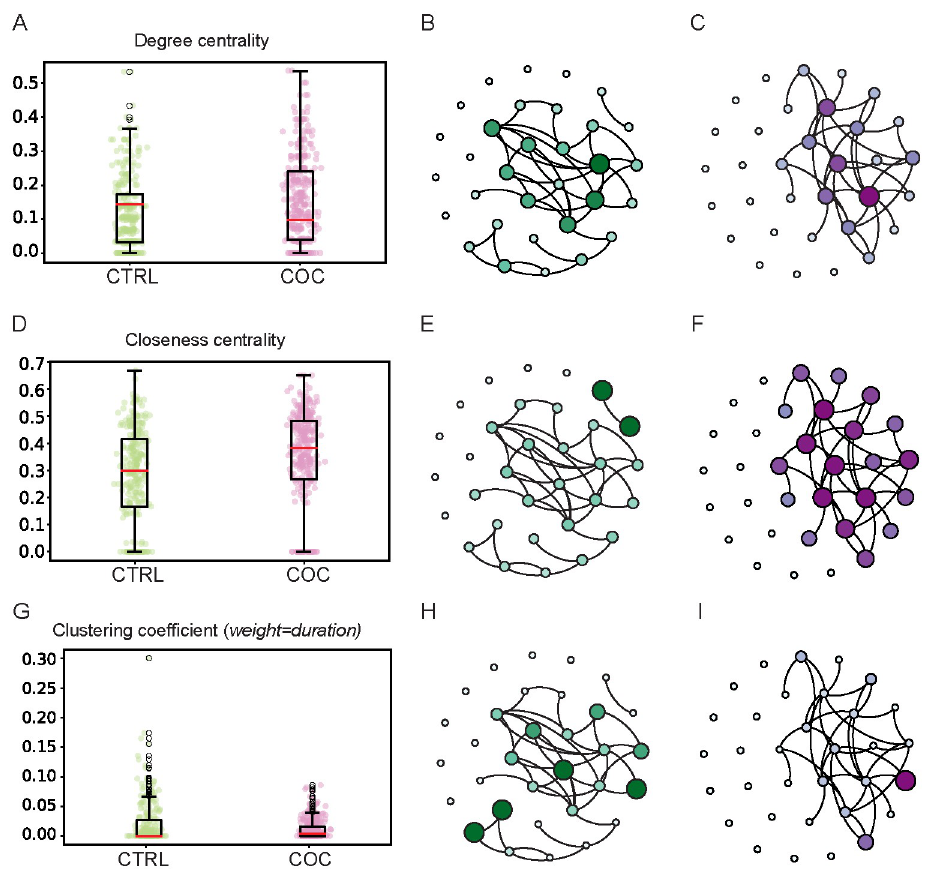
in total where A) shows COC population and B) CTRL